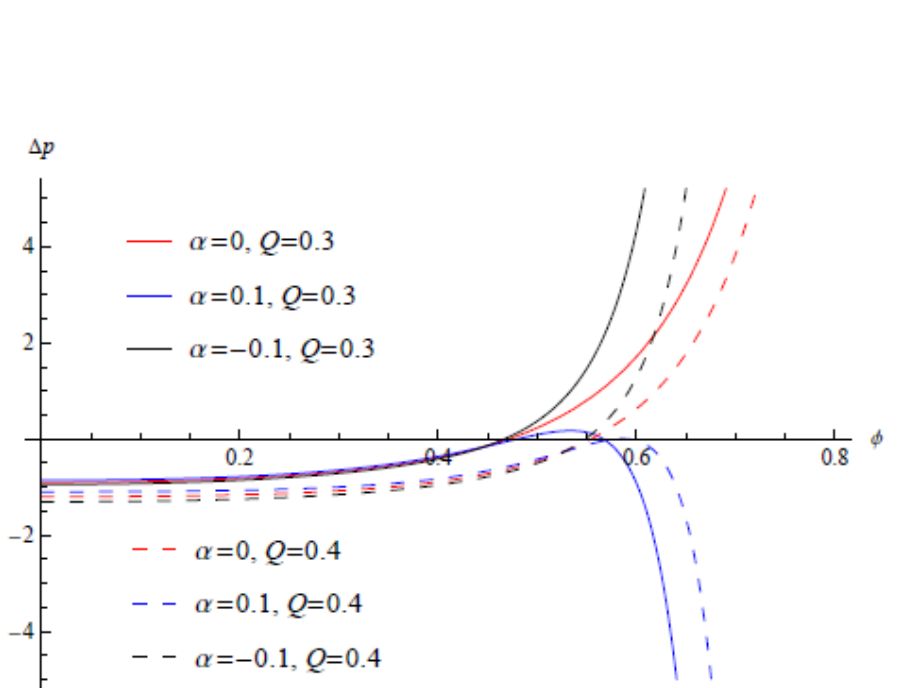
Fig. 4. Pressure rise vs. amplitude ratio for various values